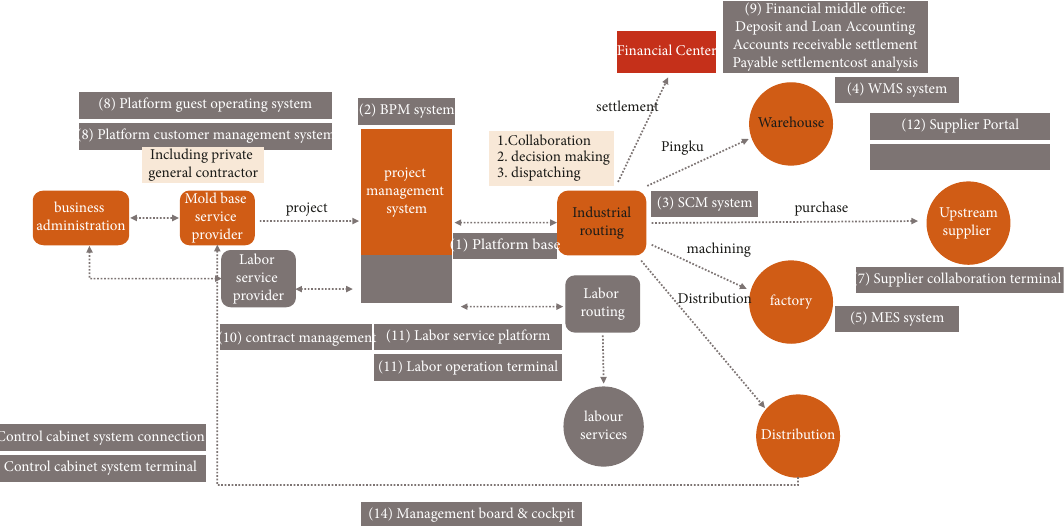
Figure 3: Visual management framework of the whole process of company operation Table 1: Description dictionary of visualization requirements.